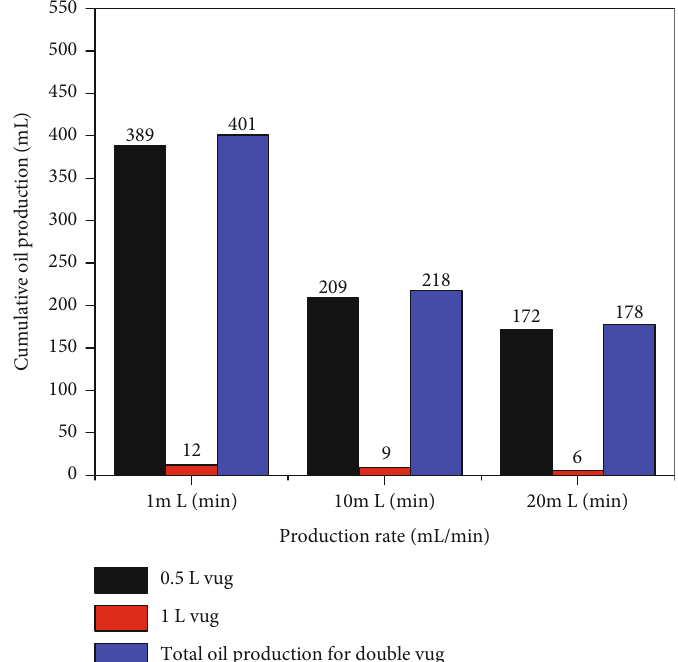
Figure 19: Column chart of cumulative oil production in high-pressure physical property experiments under connection type II (di ff erent production